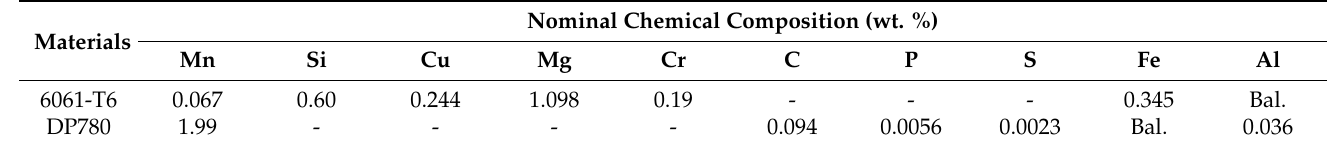
Table 1. Nominal chemical composition of base metals in wt. %.